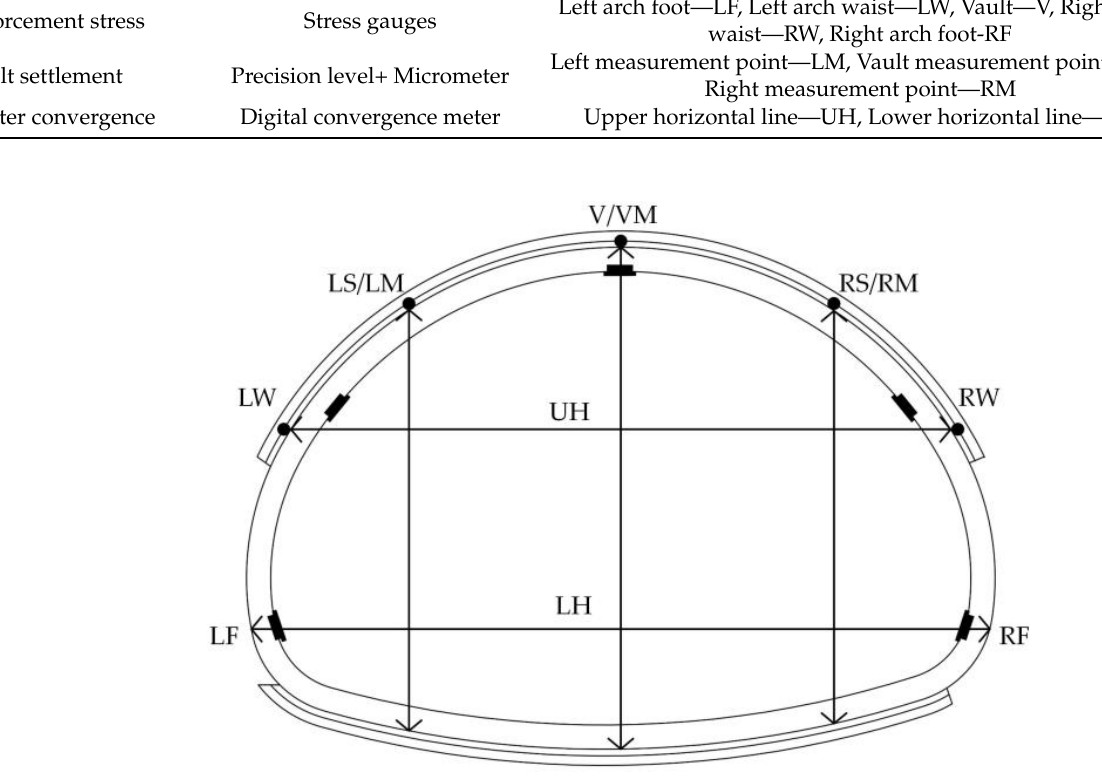
Figure 3. Measurement point layout. Table 3. List of monitoring contents and location of measurement points.